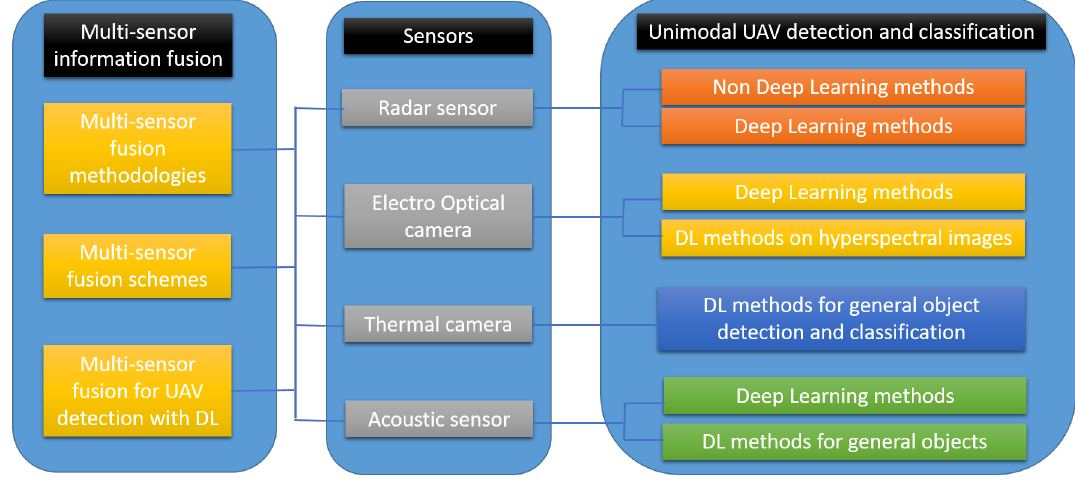
Figure 3. Overall structure of this